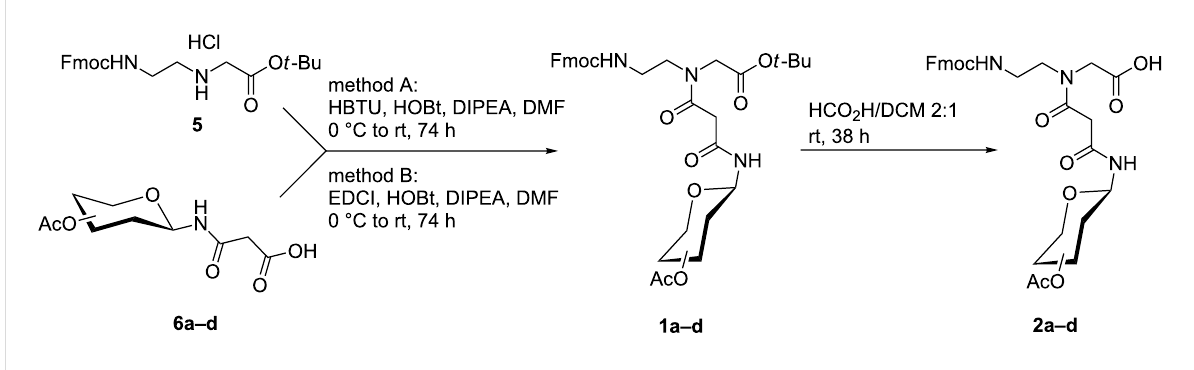
Scheme 1: Synthesis of building blocks 1a–d and 2a–d ( a stands for D-glucose, b stands for D-galactose, c stands for N -acetylglucosamine, d stands for N